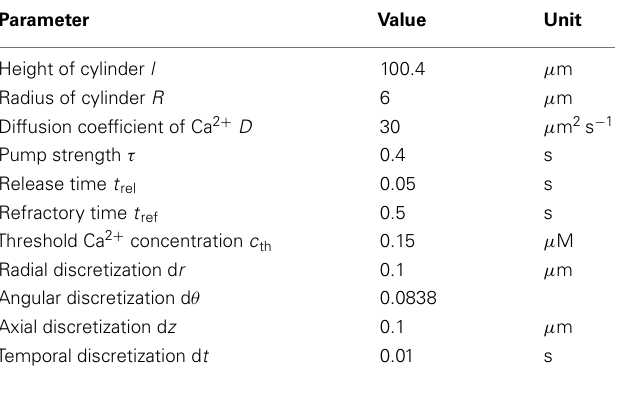
Table 1 | Default parameter values for